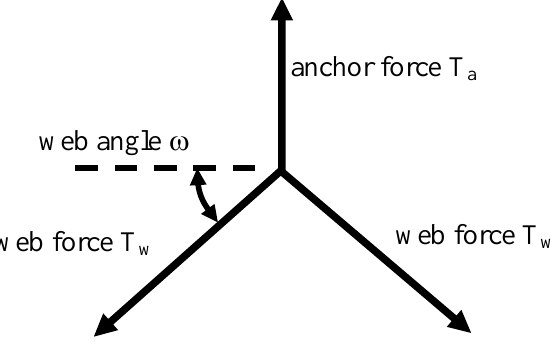
Figure 9. Free body diagram of forces acting on geocell washer/stop sleeve bearing